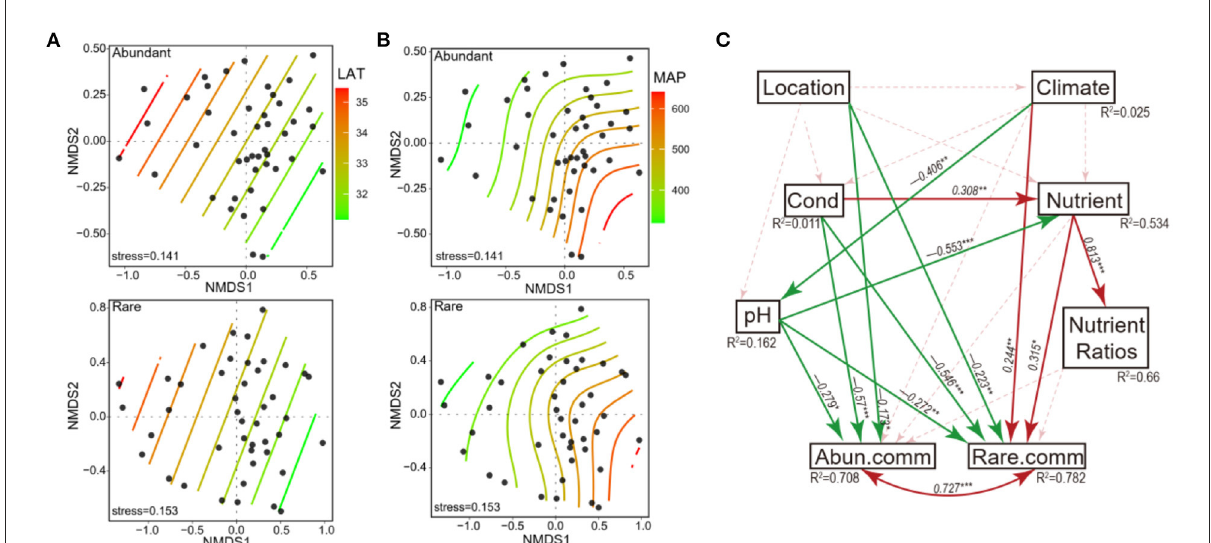
FIGURE4 Non-metric multidimensional scaling (NMDS) ordination showing the distribution of abundant and rare subcommunities along the (A) latitude gradient and (B) mean annual precipitation gradient. The contour lines show the gradients. (C) Structural equation modeling analysis illustrating the relationships between location (including latitude, longitude, and elevation), climate (including mean annual temperature and mean annual precipitation), pH, conductivity, nutrient (including sediment organic carbon, total nitrogen, and total phosphorus), nutrient ratios (including C:N, C:P, and N:P ratios), and abundant and rare subcommunities. Solid and dashed arrows represent the significant and non-significant relationships, respectively. Red and green arrows represent positive and negative relationships, respectively. The significant path coefficient is shown adjacent to the path with * , ** , and *** denote the significant level of p < 0.05, p < 0.01, and p < 0.001,